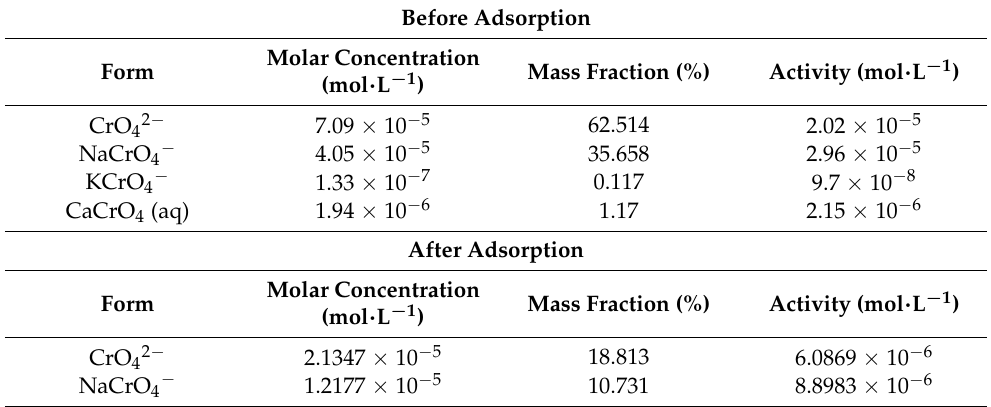
Table 3 . Speciation distribution of Cr(VI) forms in the leachate before and after adsorption Before Adsorption